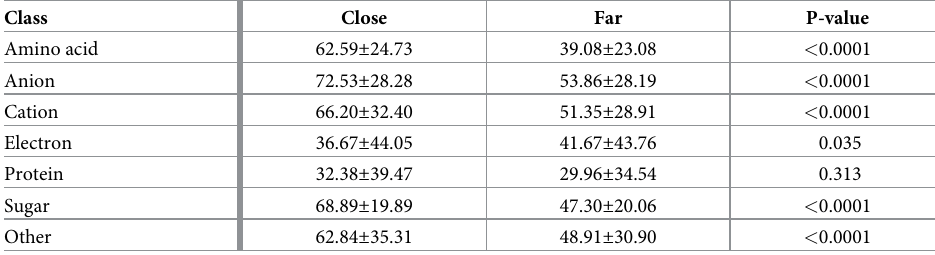
All the data are reported as the sample mean ± the standard deviation (SD). For the non-TMS regions, there are statistically (P-value < 0.0001) significant informative positions that occur close to the TMS regions (within 10 positions of the TMS) compared to other far regions, in the sequences that belong to amino acid , anion , cation , sugar , and other